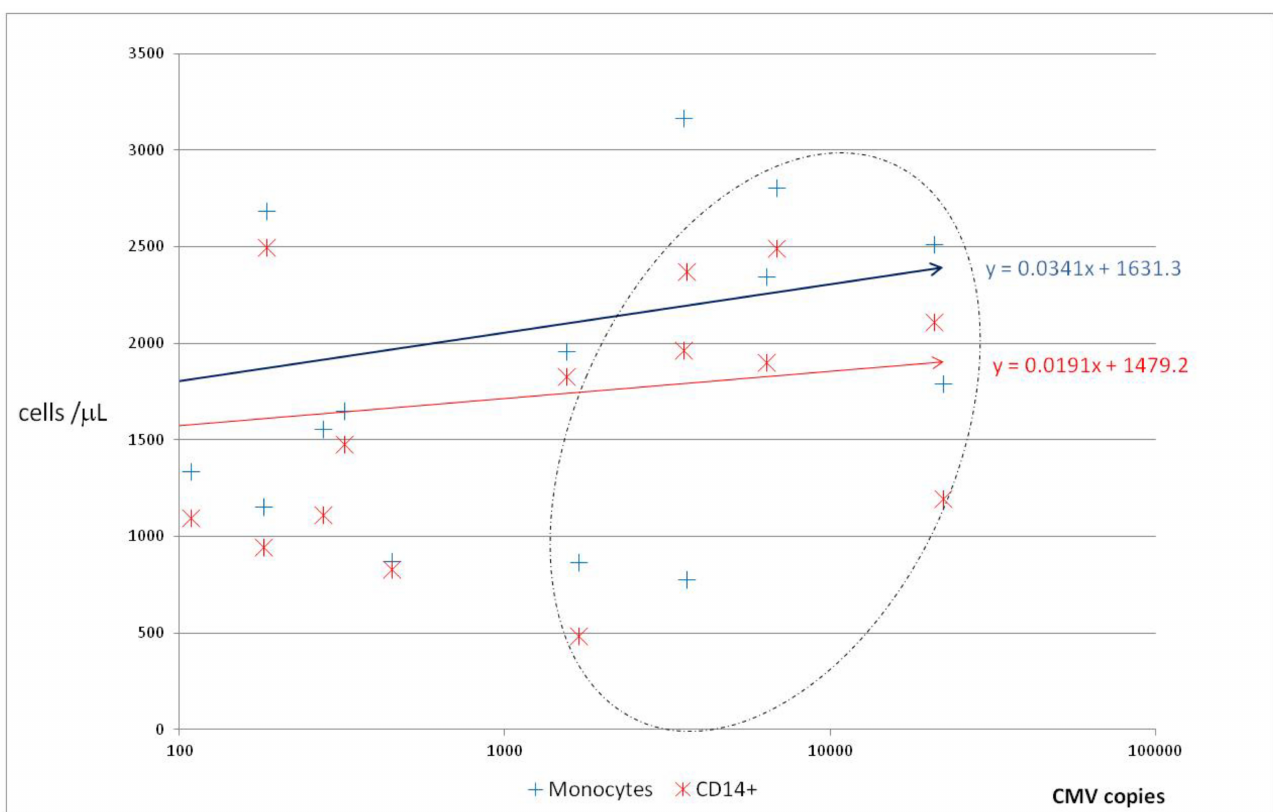
Figure 1. Regression and relationship between monocyte level (assessed with two methods) and CMV viremia—presented on vertical axis in logarithmic scale. Monocyte (hematology autoanalyzer), CD14+ cells (flow cytometry) counts are expressed on y axis.